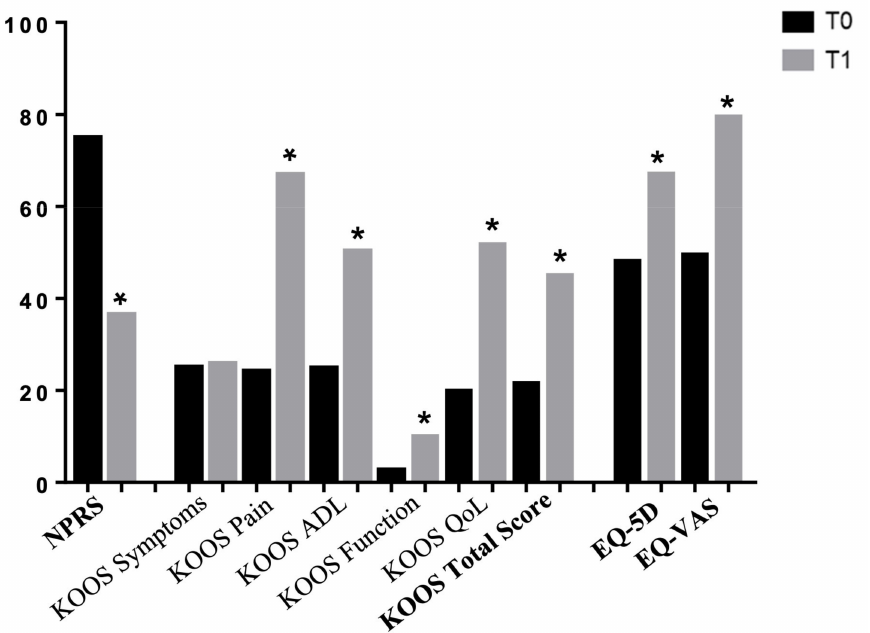
Figure 2. Differences between baseline (T0) and 1 month (T1) in the outcome measures ( n = 47). Abbreviations: ADL: Activities of daily living; EQ-5D: EuroQoL Five Dimensions; EQ-VAS: EuroQol Visual Analogue Scale; KOOS: Knee Injury and Osteoarthritis Outcome Score; NPRS: Numeric Pain Rating Scale; QoL: Quality of Life; T0: Baseline; T1: 1 Month after